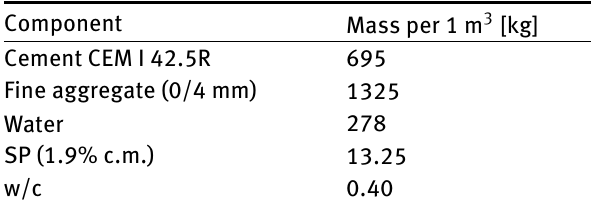
Table 2: Mortar composition. Component